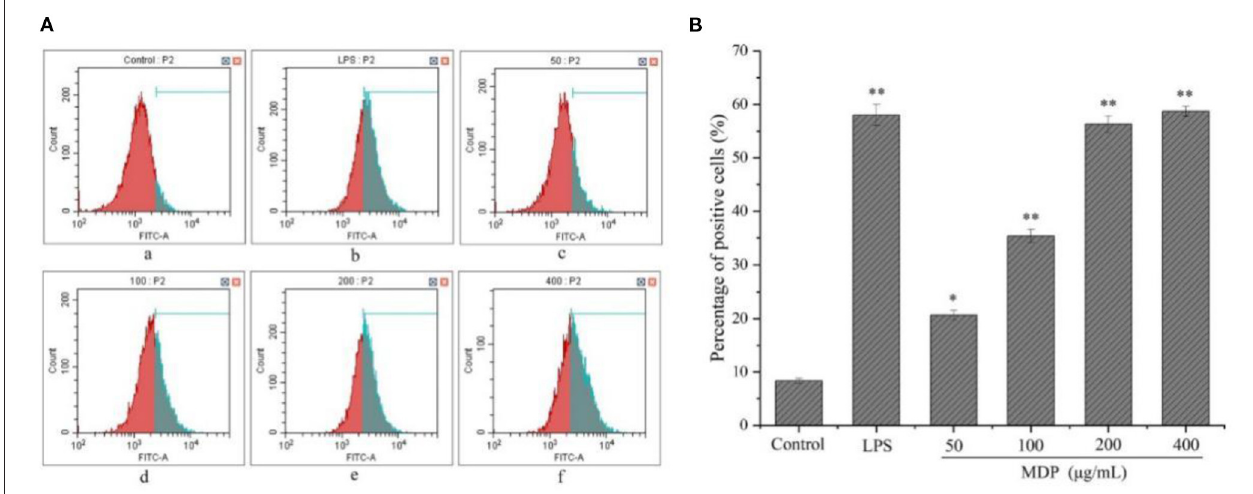
FIGURE 6 | Impacts exerted by MDP on the RAW264.7 cells’ phagocytic activity. (A) Assessment for the phagocytic activity was performed through the use of the flow cytometry (a) Control group; (b) 1 µ g/mL LPS; (c) 50 µ g/mL MDP; (d) 100 µ g/mL MDP; (e) 200 µ g/mL MDP; (f) 400 µ g/mL MDP. (B) Quantitative analysis of the RAW264.7 cells’ phagocytic activity. The values are reported as the mean